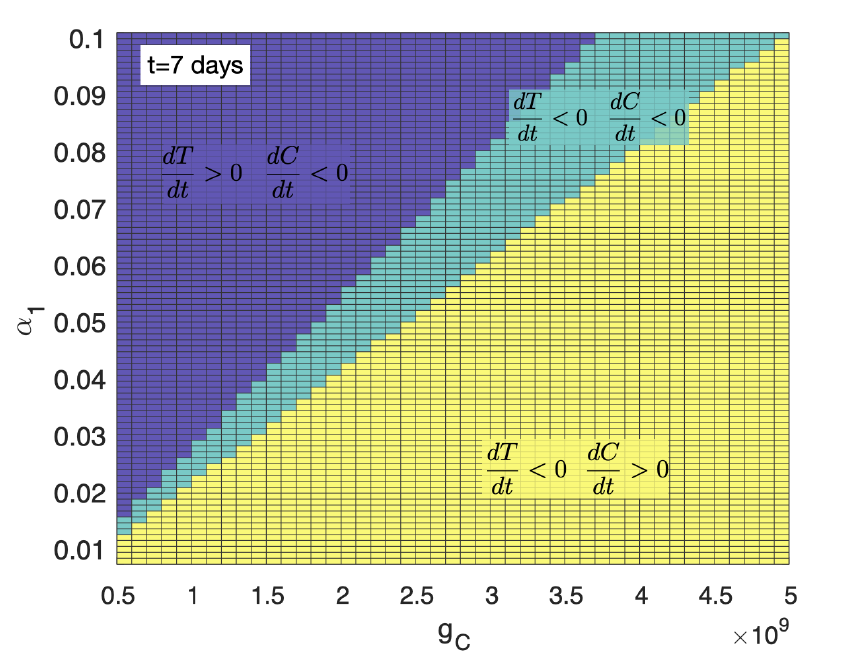
Figure 2. Parameter regions of control of the tumour growth dynamics seven days after infusion as a function of α 1 and g C . Yellow areas show the parameter areas in which dT / dt < 0, dC / dt > 0, i.e., tumour was reducing its size and CAR-T cell population increasing after seven days. Green areas are those in which dT / dt < 0, dC / dt < 0 after seven days, thus the tumour mass was reducing its size but the CAR-T cell was being destroyed by the cancer cells’ immune suppression corresponding to transient effect of the therapy. Purple regions are those in which dT / dt > 0, dC / dt < 0. Thus, the tumour was increasing its size and the CAR-T cell population decreasing after seven days, leading to therapy failure. Initial data used in the simulations were C 0 = 8 × 10 7 , T 0 = 3.35 × 10 10 and parameter values τ C = 7 days, ρ C = 0.9 day − 1 , ρ T = 1/50 day − 1 , α 2 = 2.5 × 10 − 10 day − 1 cell − 1 , g T = 10 10